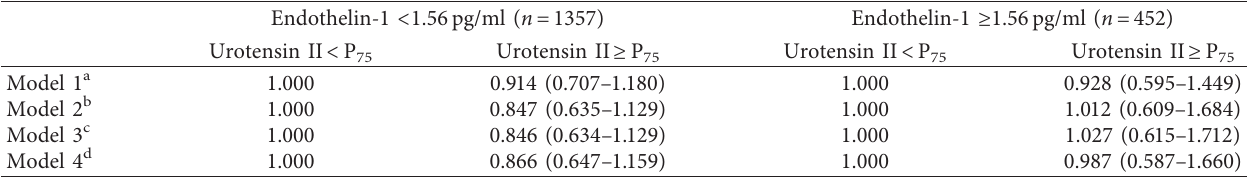
a Adjusted for age and sex; b adjusted for age, sex, and systolic blood pressure at baseline; c adjusted for age, sex, systolic blood pressure, drinking, smoking, and family history of hypertension; d adjusted for age, sex, systolic blood pressure, drinking, smoking, family history of hypertension, body mass index, fasting plasma glucose, and total